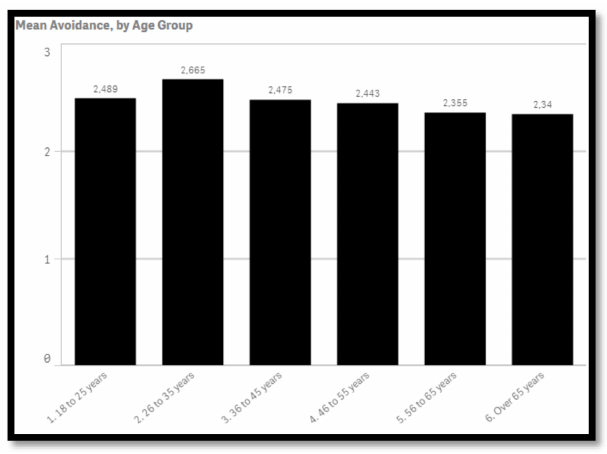
Figure 3. Avoidance, by age. Source: data study